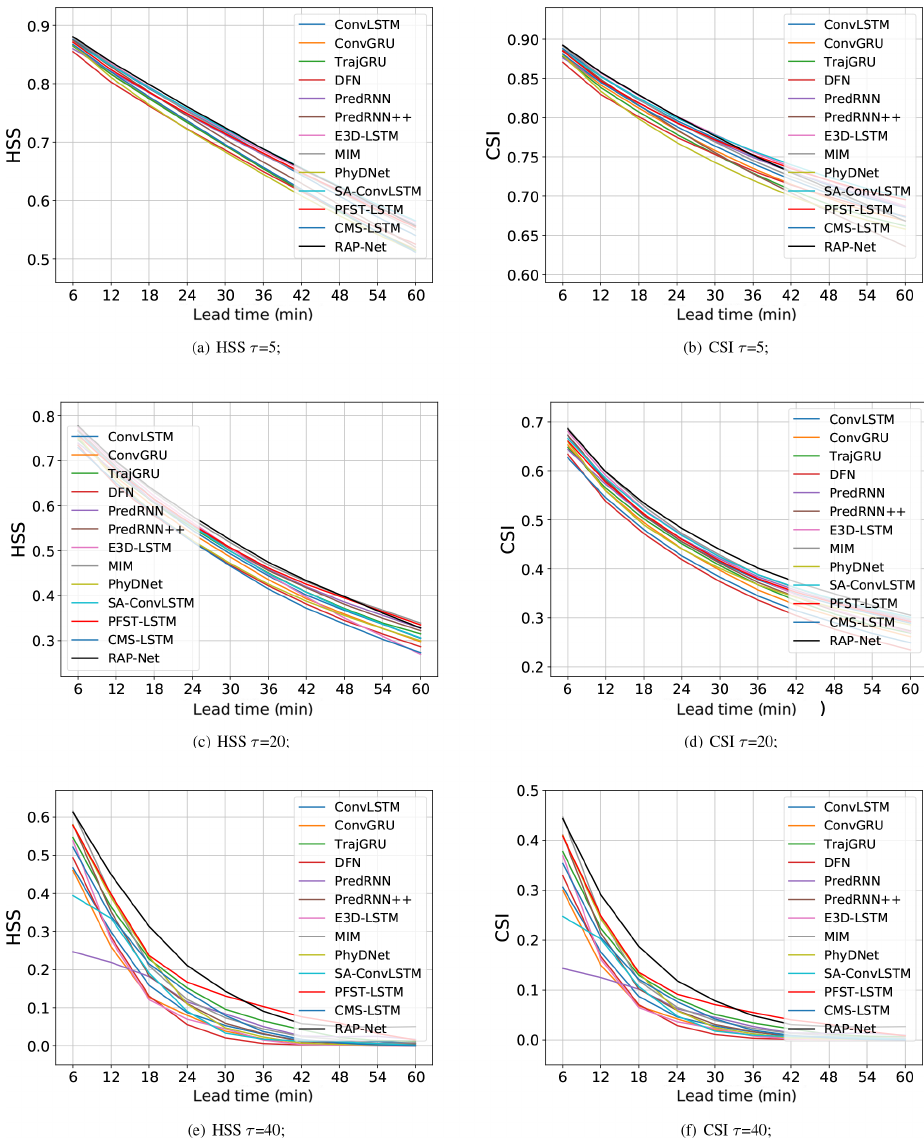
Figure 6. The HSS and CSI scores of different case lead time values (best viewed in